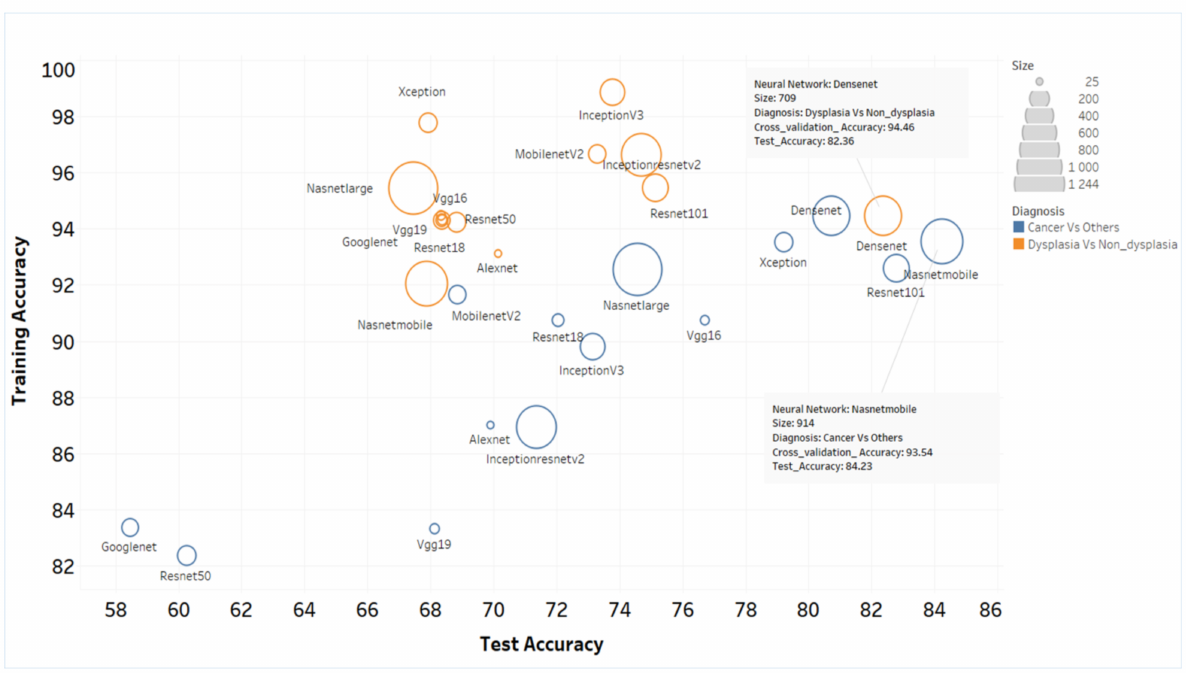
Figure 5. Accuracy of the various ANN-SVM models in delineating the patient cohorts. The training and test accuracy of the 14 neural networks used in the study in delineating cancer from dysplasia/non-dysplastic lesion and dysplasia from non-dysplastic lesions were depicted. The size of circle represents the size of neural network. The less overfitting models were NASNetMobile and DenseNet-201.